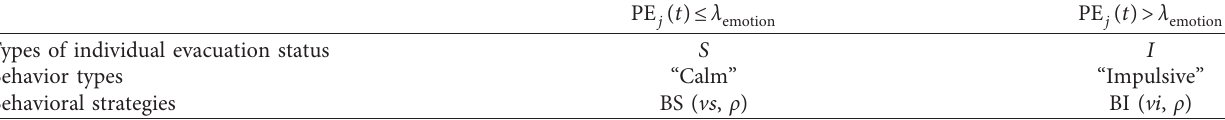
Figure 9: Emotional renewal mechanism of evacuation individual j at time t . Table 1: Mapping relationship between emotional intensity and behavior types of evacuation